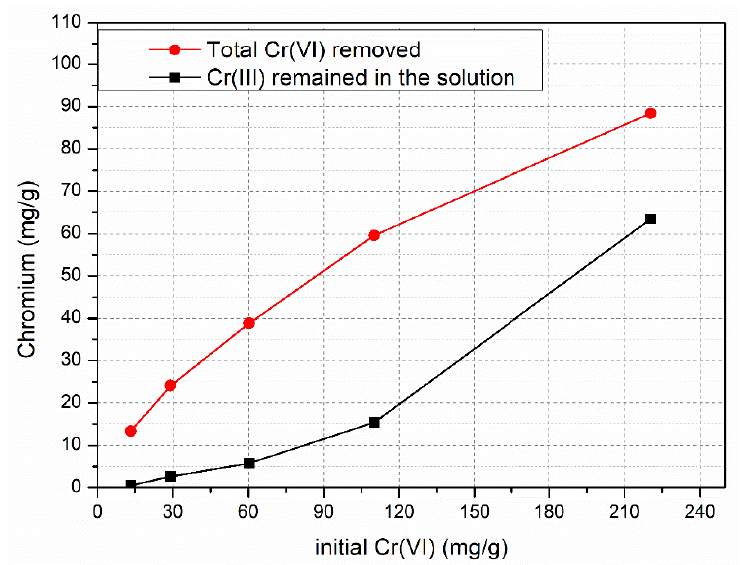
Figure 9. Remaining quantity of Cr(III) in the solution after the sorption experiments with mAC-snack at different initial Cr(VI) concentration in comparison with the total quantity of Cr(VI) removed from the solution.